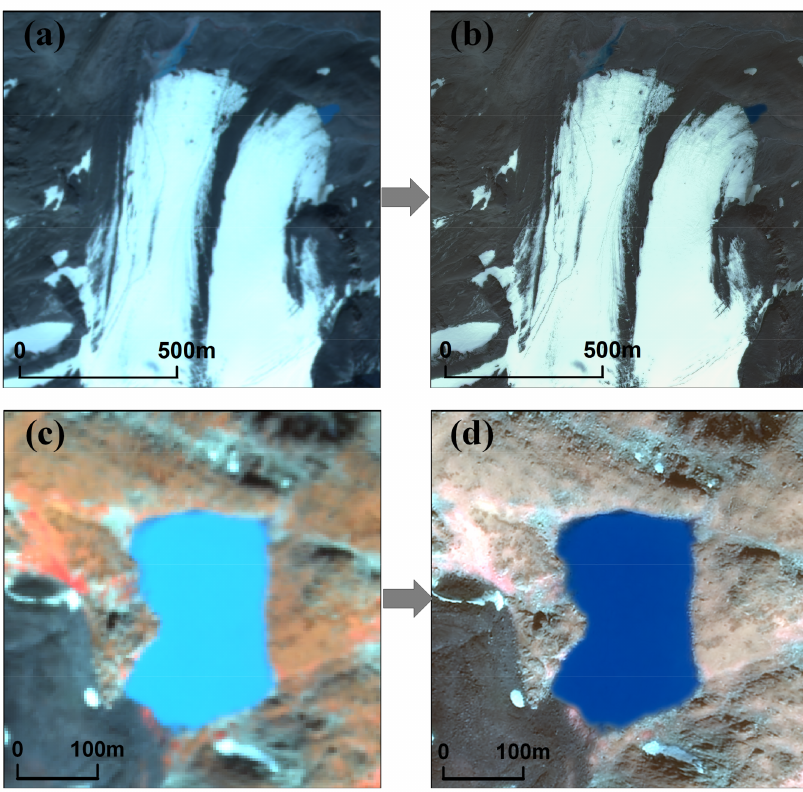
Figure 4. Improvement in spatial resolution and visual content of the glacier ( a , b ) and glacial lake ( c , d ) in the false color composite (FCC, RGB 432) satellite scene after